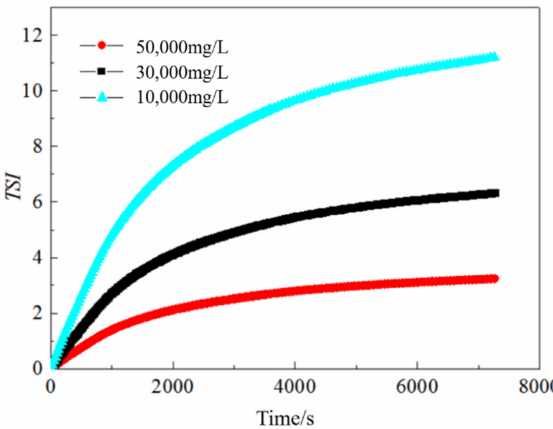
Figure 13. Relationship between TSI and